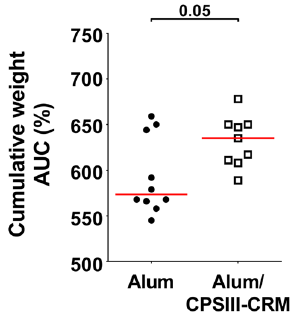
Figure 2. Maternal vaccination prevented weight loss in pups challenged with GBS M781 serotype III strain. Computed AUC (area under the curve) of normalized body weights of pups from alum/CPSIII-CRM- or alum-vaccinated mothers within the first 4 days following intranasal challenge with GBS M781 serotype III strain. Data were analyzed as increment of weight as compared with the initial weight of single animals (100%— normalized data) and finally AUC were calculated. Each dot represents the value of a single mouse. Data from 9 to 10 pups/group from one mother are reported. The Mann–Whitney U test was used to assess statistical